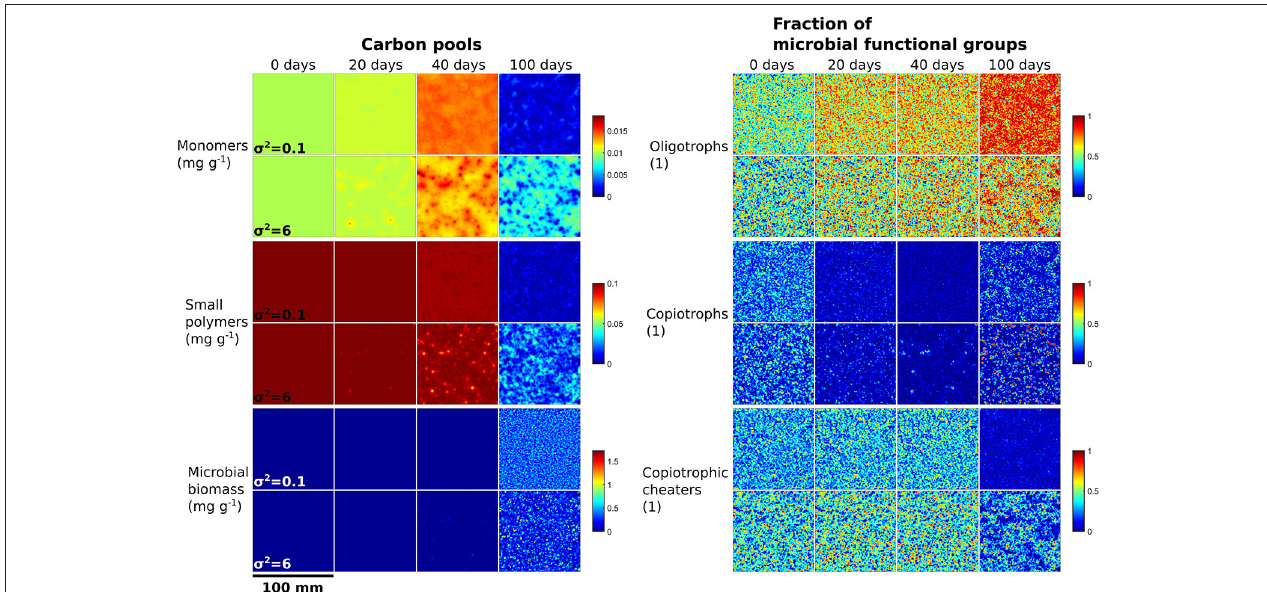
FIGURE 3 | Microbial biogeography triggers the emergence of spatial patterns of carbon utilization and microbial succession. Each square exemplifies the spatial distribution of C pools (left) and the fraction of microbial functional groups of the total microbial biomass (right) for low ( σ 2 = 0.1) and strong ( σ 2 = 6) initial spatial clustering of microbial communities within a 100 × 100 mm 2 soil domain for one stochastic realization.